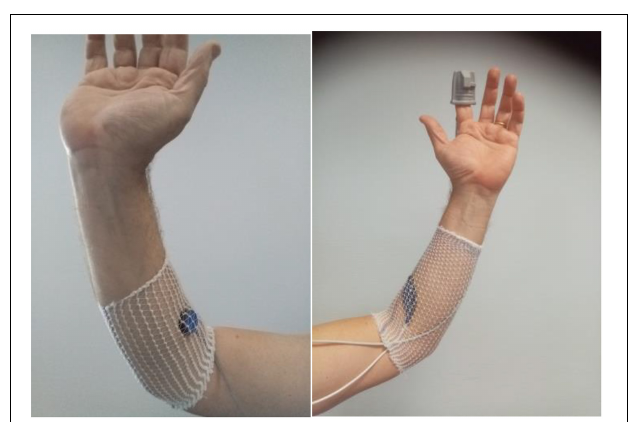
FIGURE 2 | Illustration of the location of probes. The left panel shows the IR light V-PPG probe of the ELCAT device on the forearm close to the elbow crease; the right panel shows the probes at the fingertip and forearm level used during the red light V-PPG recordings.